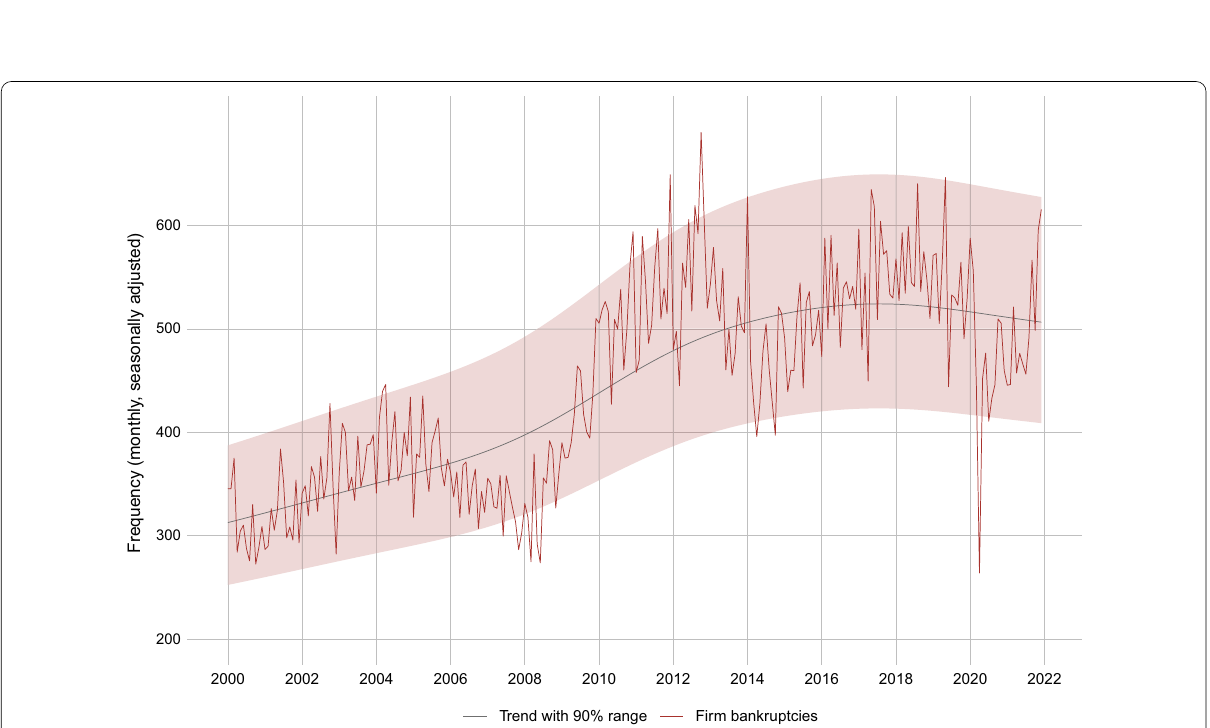
Fig. 14 Monthly firm bankruptcy rate in Switzerland. Notes : The figure shows the monthly bankruptcy rate ( frequency of total firm bankrupcties excluding SCO Art. 731b cases divided by the total stock of firms) in Switzerland over time. The stock of firms are available since September 2007 only, which limits the history of the time series. The time series seems to have a downward trend, however, this might be driven by cyclical movements both at the beginning of the series (Great Recession) and at the current end of the series (COVID-19 crisis)